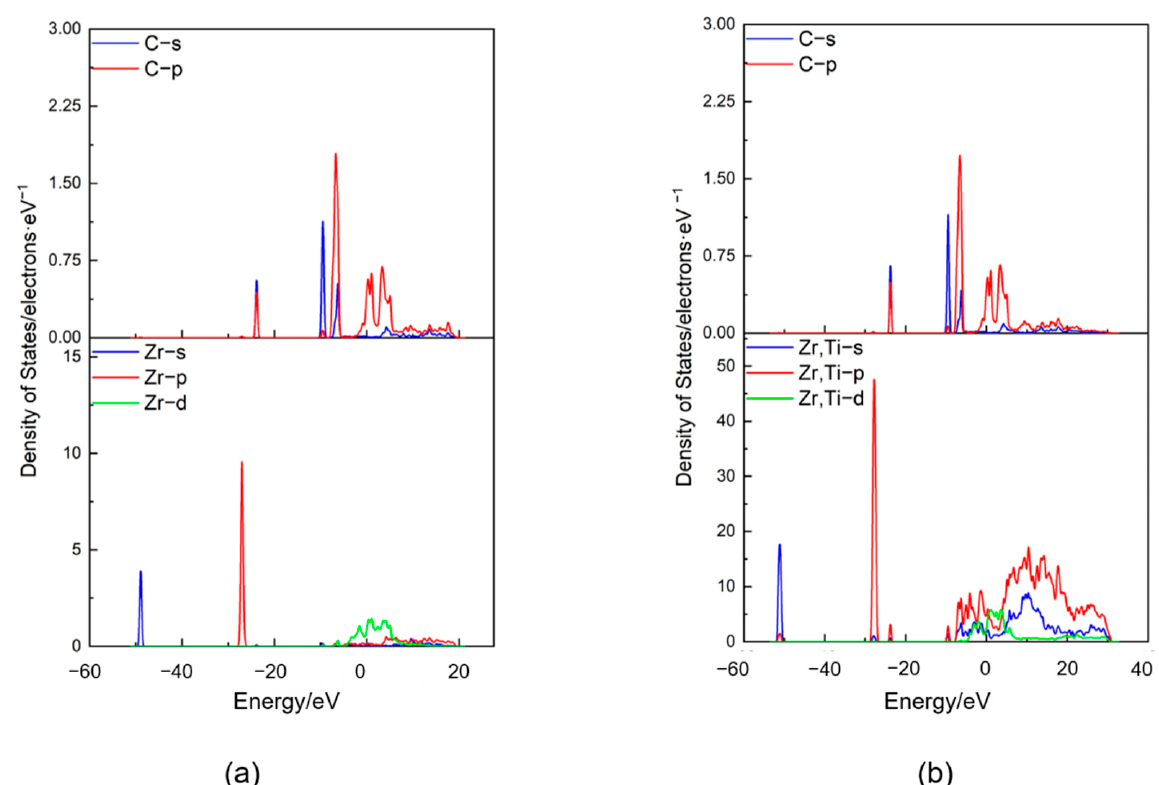
Figure 4. PDOS of C and Zr atom with CO adsorbed on ( a ) ZrCo (110) and ( b ) Zr 0.8 Ti 0.2 Co (110).